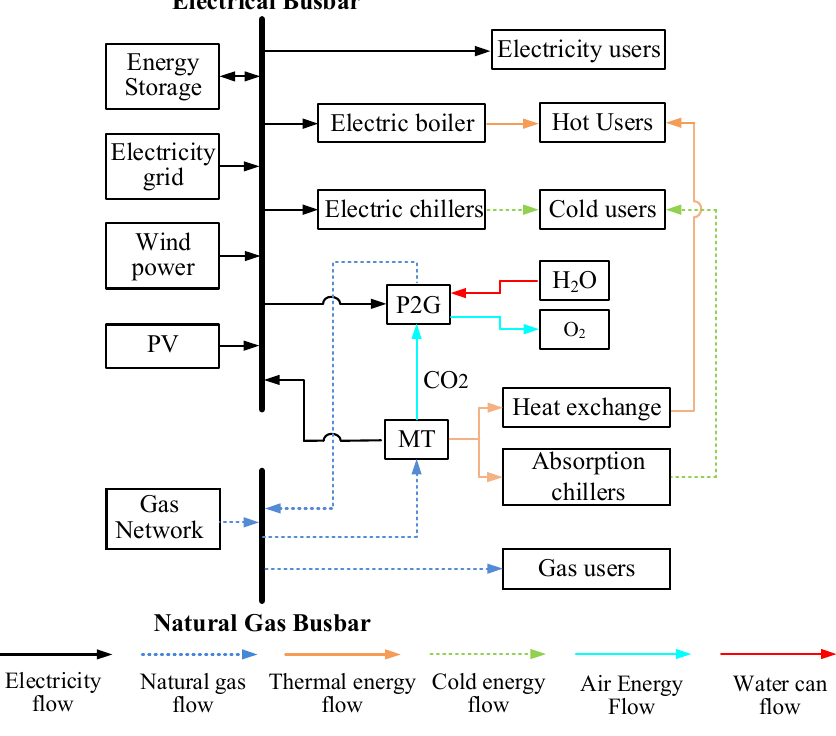
Figure 1. Framework of the electrical integrated energy system.